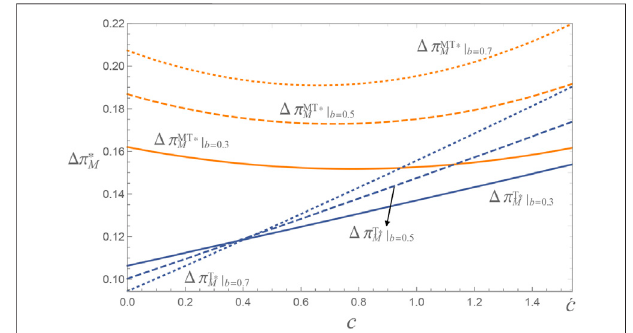
FIGURE 3 | The manufacturer ’ s pro fi t. ( a (cid:1) 1